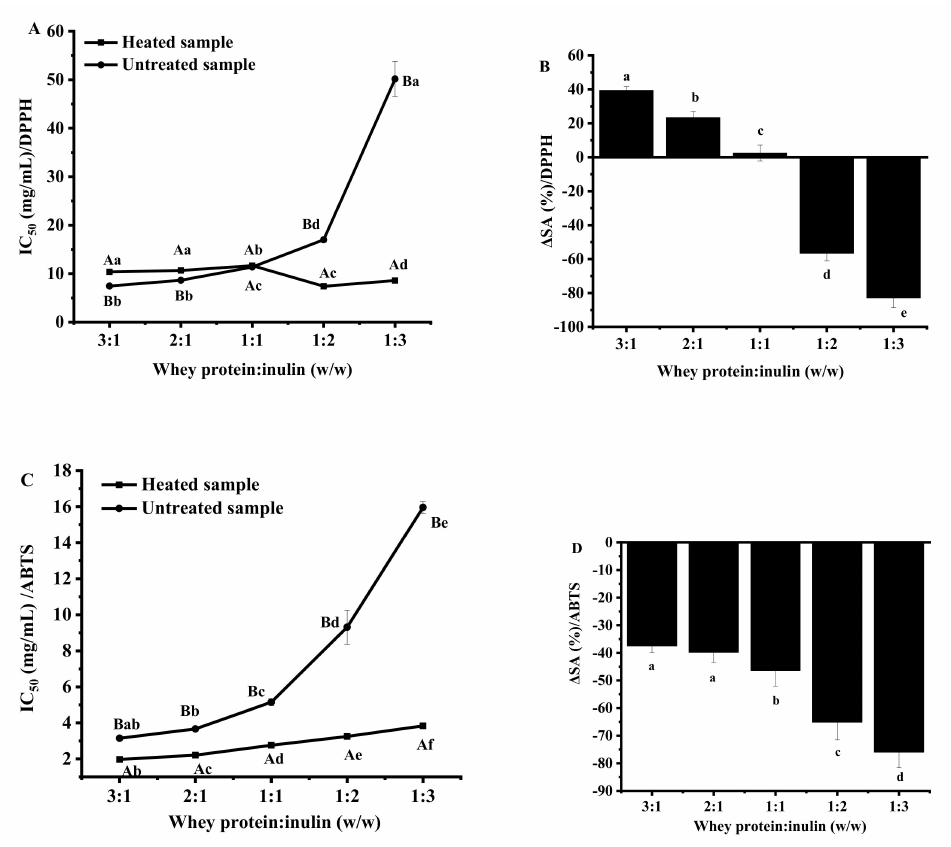
Figure 5. Changes in IC 50 values of 2,2-diphenyl-1-picrylhydrazyl (DPPH) ( A and B ) and 2,2 (cid:48) -azinobis(2-ethylbenzothiazoline-6-sulfonate) (ABTS) ( C , D ) radical scavenging activities of whey protein and inulin mixture after dry heating. Di ff erent lowercase letters denote significant di ff erence in IC 50 values of DPPH or ABTS scavenging activities between samples with di ff erent whey protein and inulin ratios for untreated or dry-heated samples; Di ff erent uppercase letters denote significant di ff erence in IC 50 values of DPPH or ABTS scavenging activities between untreated and dry-heated samples at same whey protein and inulin